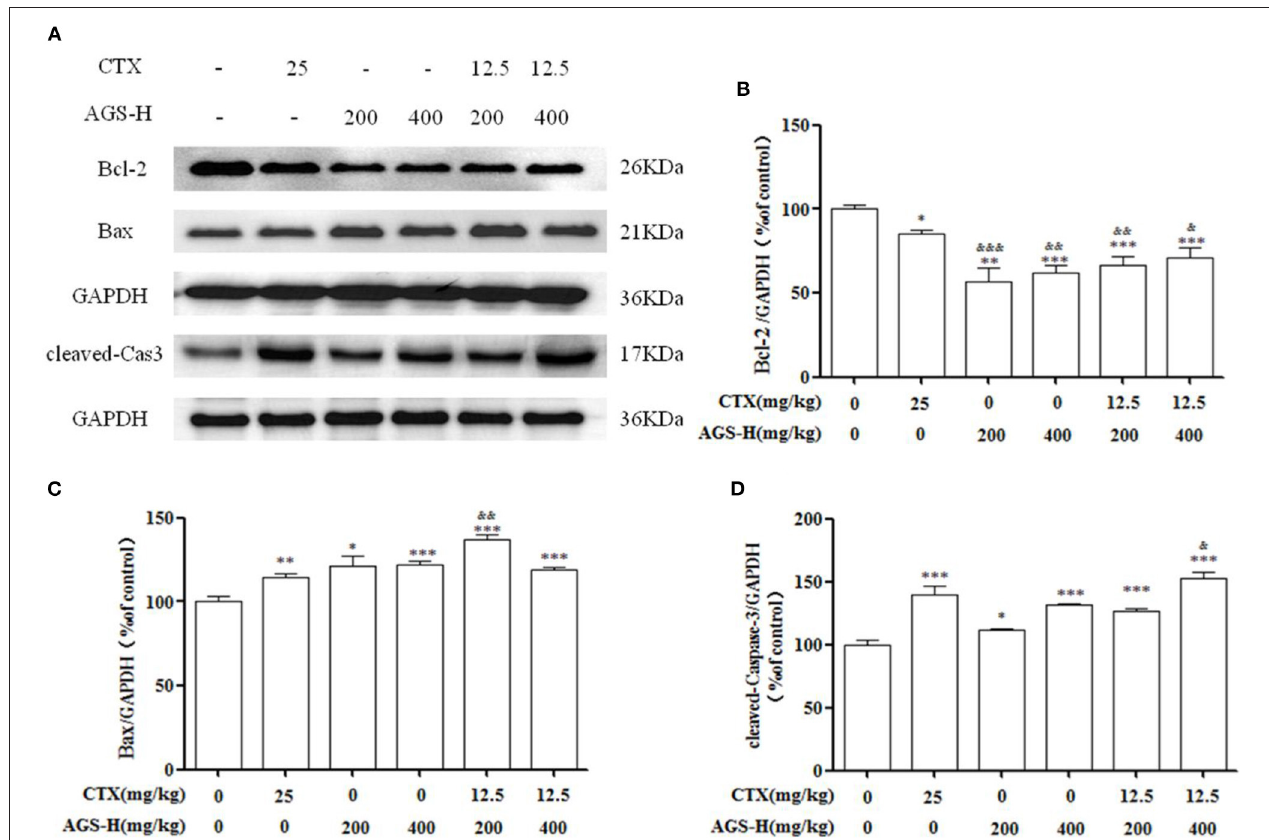
FIGURE 10 | Effects of AGS-H synergistic CTX/2 on Bcl-2, Bax and cleaved Caspase-3 in S180 tumor-bearing mice ( n = 8). (A) The protein expression levels of Bcl-2, Bax and cleaved-Caspase-3 were detected by Western blotting. (B) The relative Bcl-2 expression level. (C) The relative Bax expression level. (D) The relative cleaved-Caspase-3 expression level. Values are presented as mean ± SD. vs. model group, * P < 0.05, *** P < 0.001; vs. CTX group, & P < 0.05, && P < 0.01, &&& P <